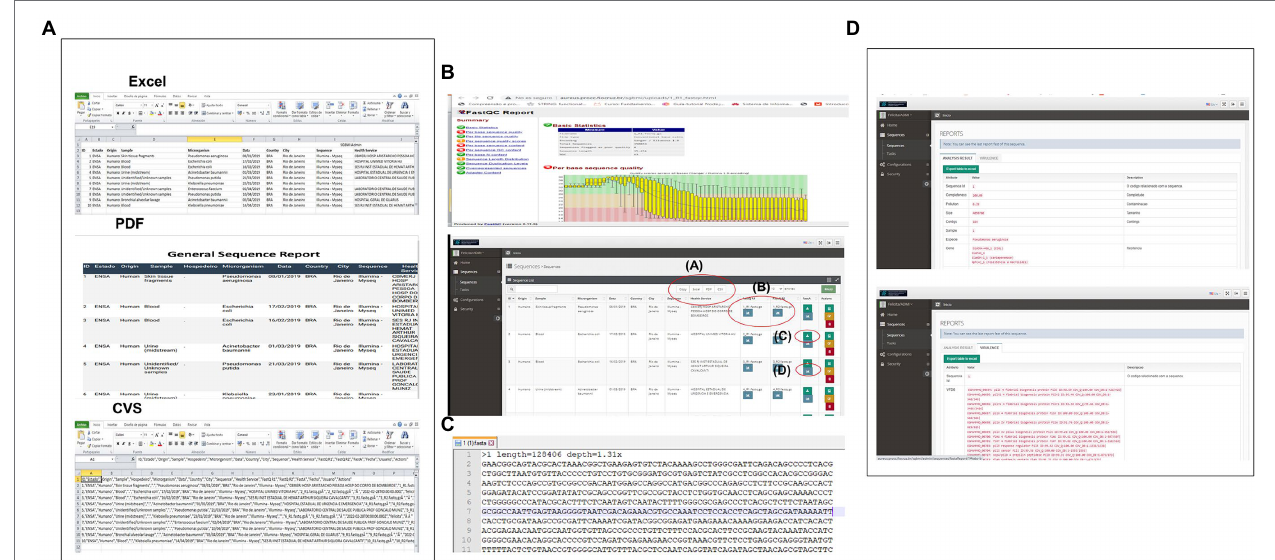
FIGURE 3 | System Output (A) In this section, you can download the entire list of user sequences, in Excel, pdf, CVS formats, or just plain text. (B) By clicking on this icon you can view the HTML report generated by FASTQC (Sequence Quality Control) in which the user can navigate through the sections offered. (C) In this icon, you can access the file in fasta format that is obtained when assembling the reads. (D) In this section, you can access the individual report of the sequences with all the results obtained from each of the steps of the Pipeline